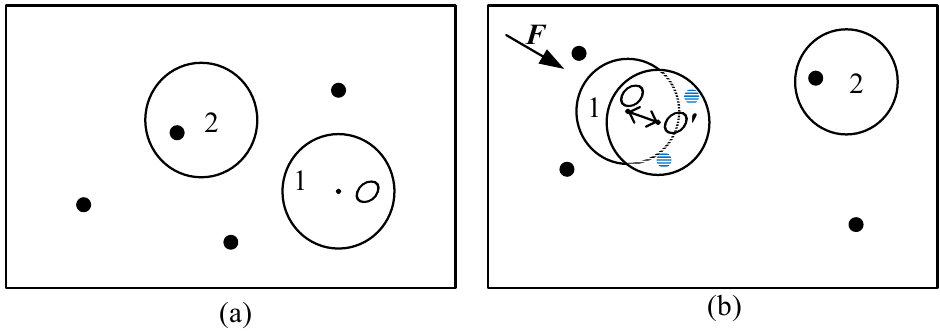
Figure 4. Diagram of selected anchor position of ship. ( a ) The diagram of ship anchor position selection under no influence of wind and current. ( b ) The diagram of ship anchor position selection under influence of wind and current.